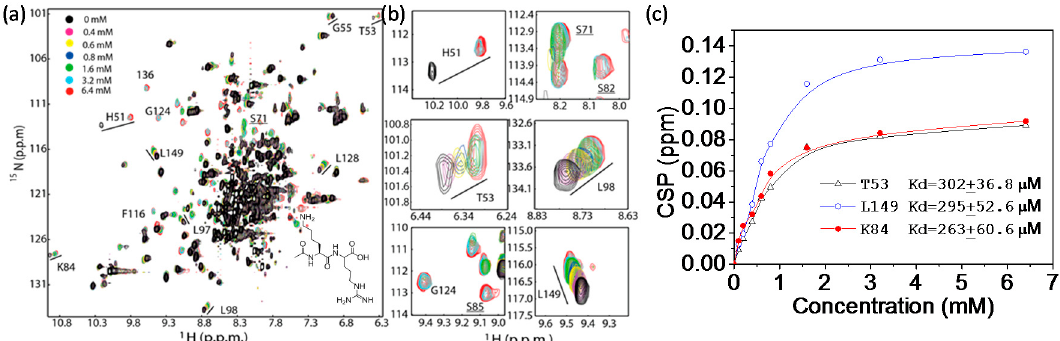
Figure 5. Kd determination using 2D-HSQC-type of experiment. ( a ) 1 H- 15 N-HSQC spectra of Zika virus protease in the absence and presence of different amounts of dipeptide. Inset is the structure of the peptide used in the experiments; ( b ) Chemical shift changes of several residues. The binding is a complicated process. H51 is undergoing slow or intermediate exchange. Some other residues are undergoing intermediate exchanges and their resonances appeared in the presence of the peptide. Peptide concentration dependent CSP are also observed for several residues close to the protease active site; ( c ) The CSP caused by peptide binding is plotted against peptide concentration. The Kd value for several residues (T53, L149, K84) which are undergoing fast exchange are determined. This figure is obtained from the reference [141] with slight modifications.